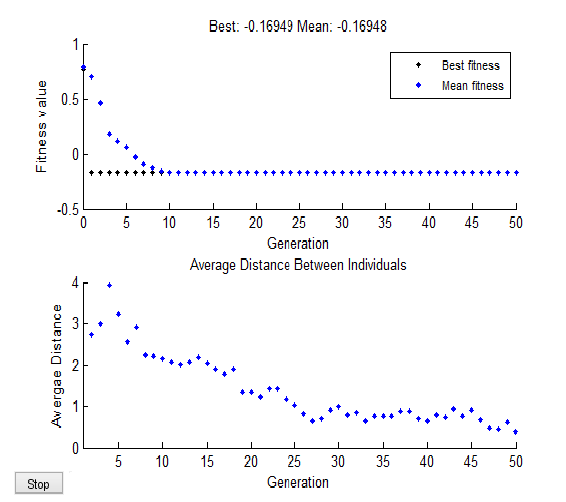
output of Fig. 14. Best fitness value for :; > trajectory and average distance between